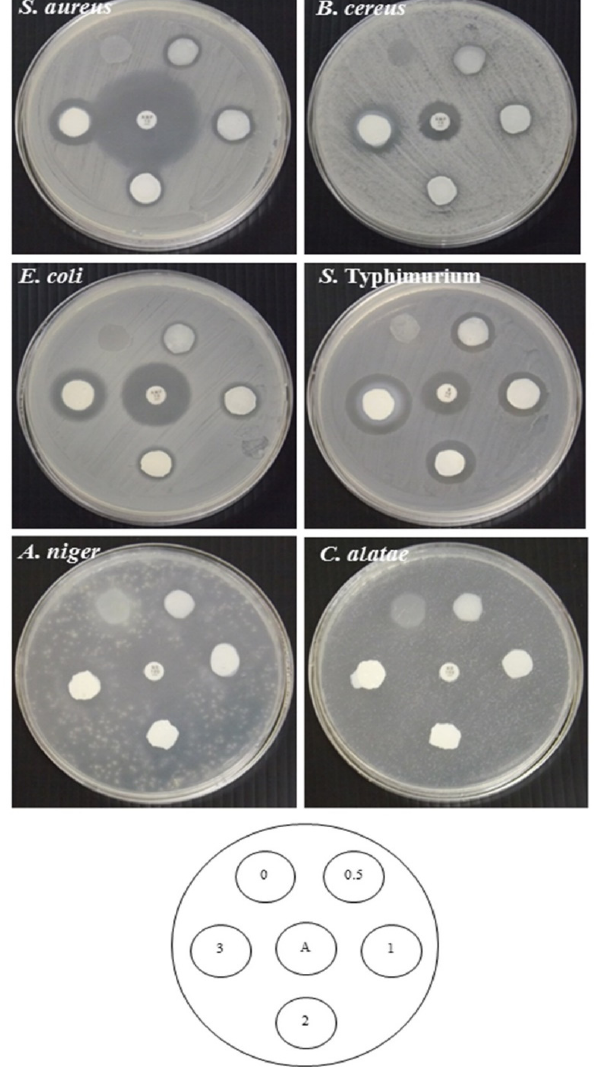
Figure 5. Antimicrobial properties of RS–G films containing different concentrations of ZnONPs. The numbers designate of ZnONPs concentrations (%, w / v ). A: ampicillin (10 µ g/disc), streptomycin (10 µ g/disc), and nystatin (100 units/disc).